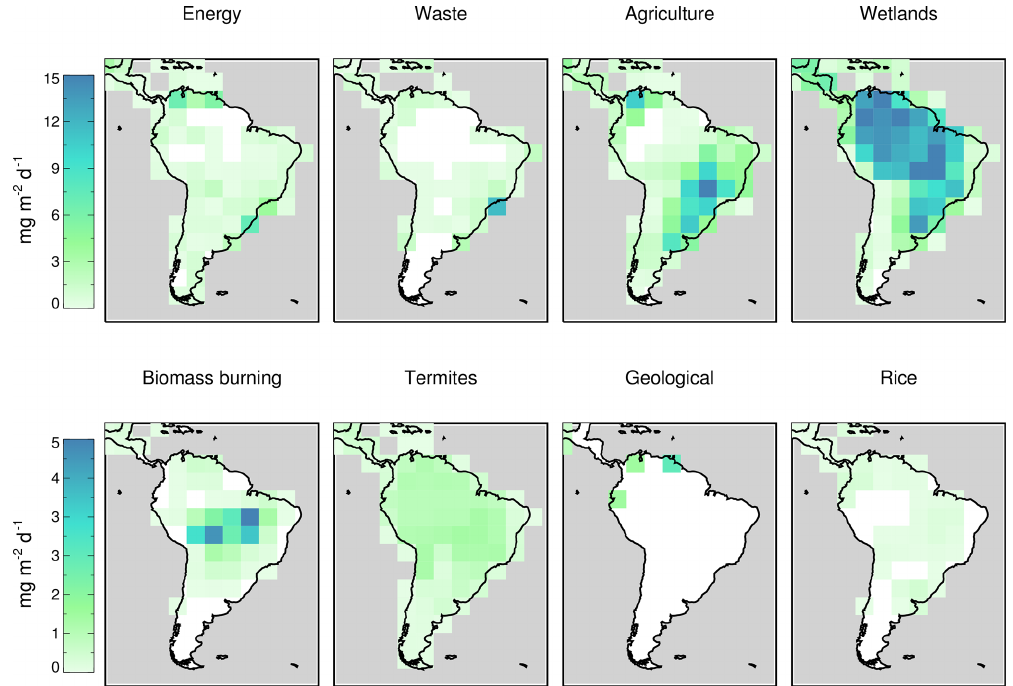
Figure A2. A priori gridded sectoral South American CH 4 emissions (mgm − 2 d − 1 ) for 2010. Note different colour scales for top and bottom rows. Description of sectoral emissions are in Sect. 2.2.2 of the main text. Here, the “Energy” sector refers to the energy industry, oil and gas production, and energy for buildings and transportation; “Waste” refers to solid waste disposal and waste water; “Agriculture” refers to enteric fermentation and manure